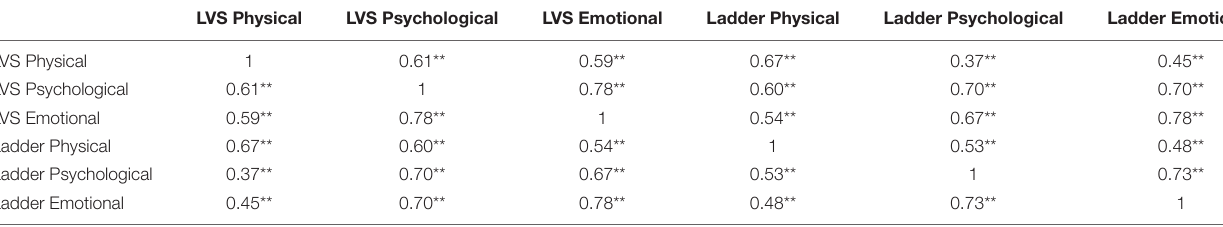
TABLE 6 | Convergent validity of the LVS factors and Cantril’s ladder vitality